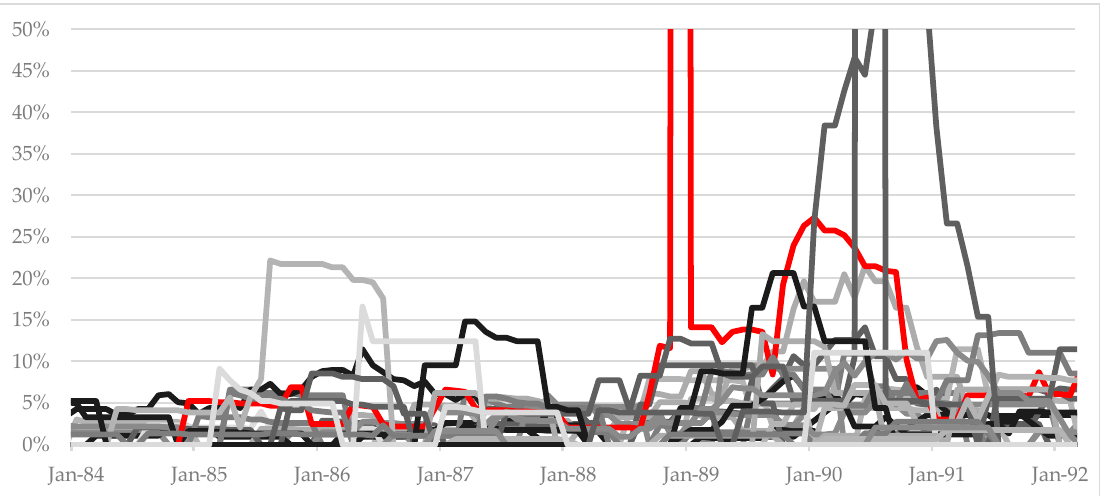
Figure 6. Sectoral default rates around the late 1980s downturn in credit conditions. Source: Author’s calculations and Moody’s. Note that the exhibit presents sectoral default rates for 33 non-financial corporate sectors. The vertical axis was deliberately limited to 50% to illustrate volatility within and across sectors relative to lower default rates in some time periods. The “hotels and gaming” sector is highlighted in red, as it is the first sector that saw its default rate jump sharply and persist higher during the course of 1998/1999. Table 2. Percentage of sectors exhibiting contagion compared with “leading” sector. Source: Author’s calculations. Note that the sectors with negative “stress” correlation coefficients were excluded from the percentages presented. The contagion tests were calculated as specified in Table 1 using the sample periods specified in the main text.